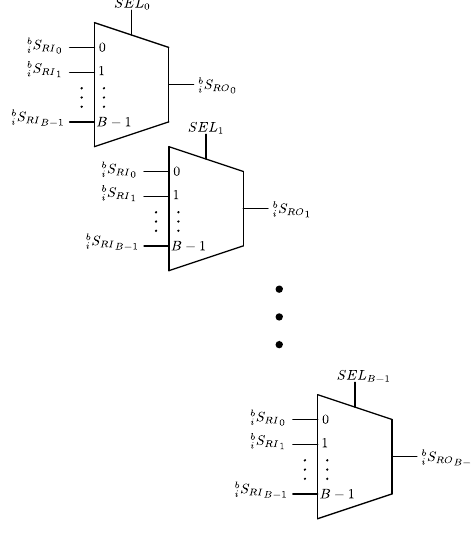
Figure 7. Hardware Implementation of the